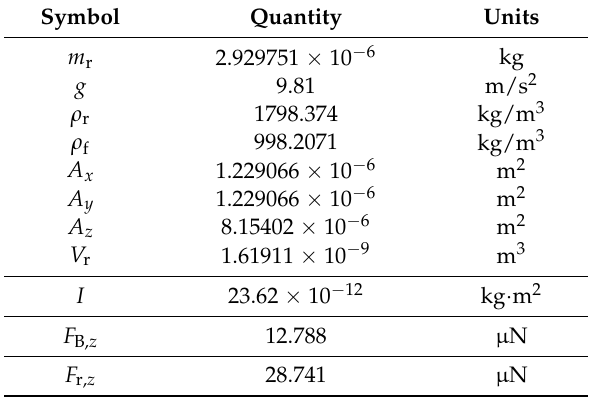
Table 2. Micro-untethered floating object (Micro-UFO) properties and nonmagnetic